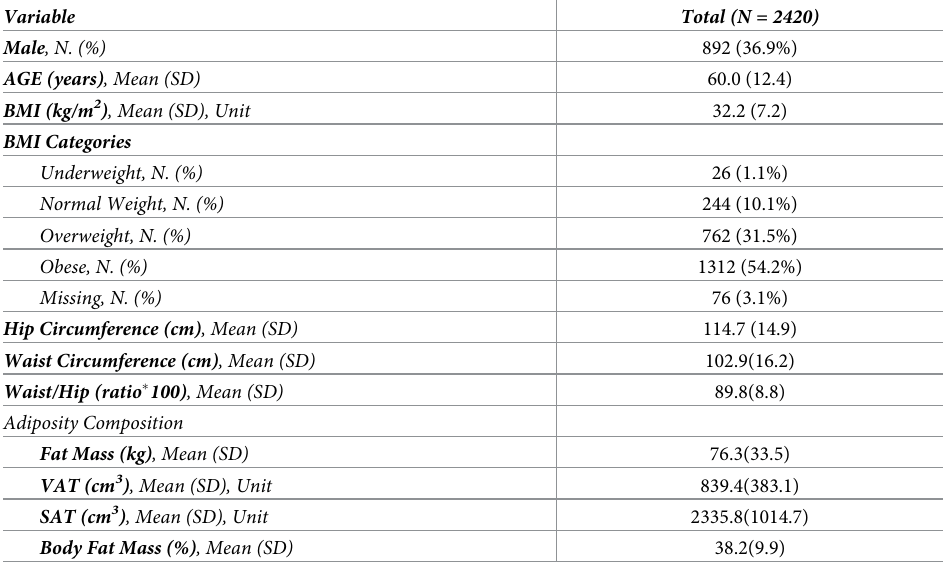
Table 1. Baseline characteristics of the study participants.